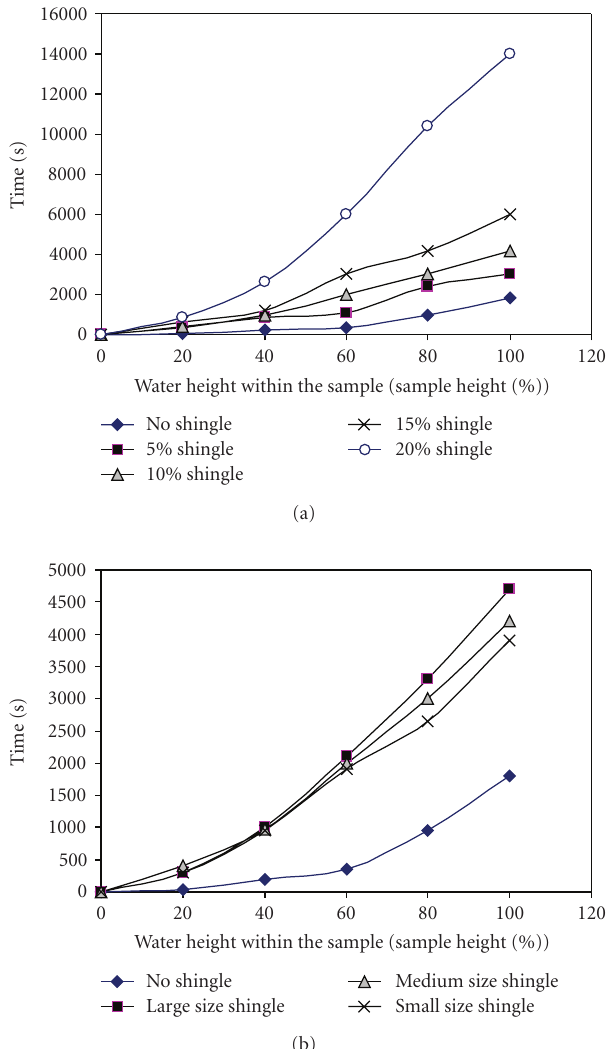
Figure 6: Capillary rise time required for di ff erent percentage heights: di ff erent shingle contents (10% CKD and medium shingle size) and (b) di ff erent shingle sizes (10% CKD and 10% shingle).